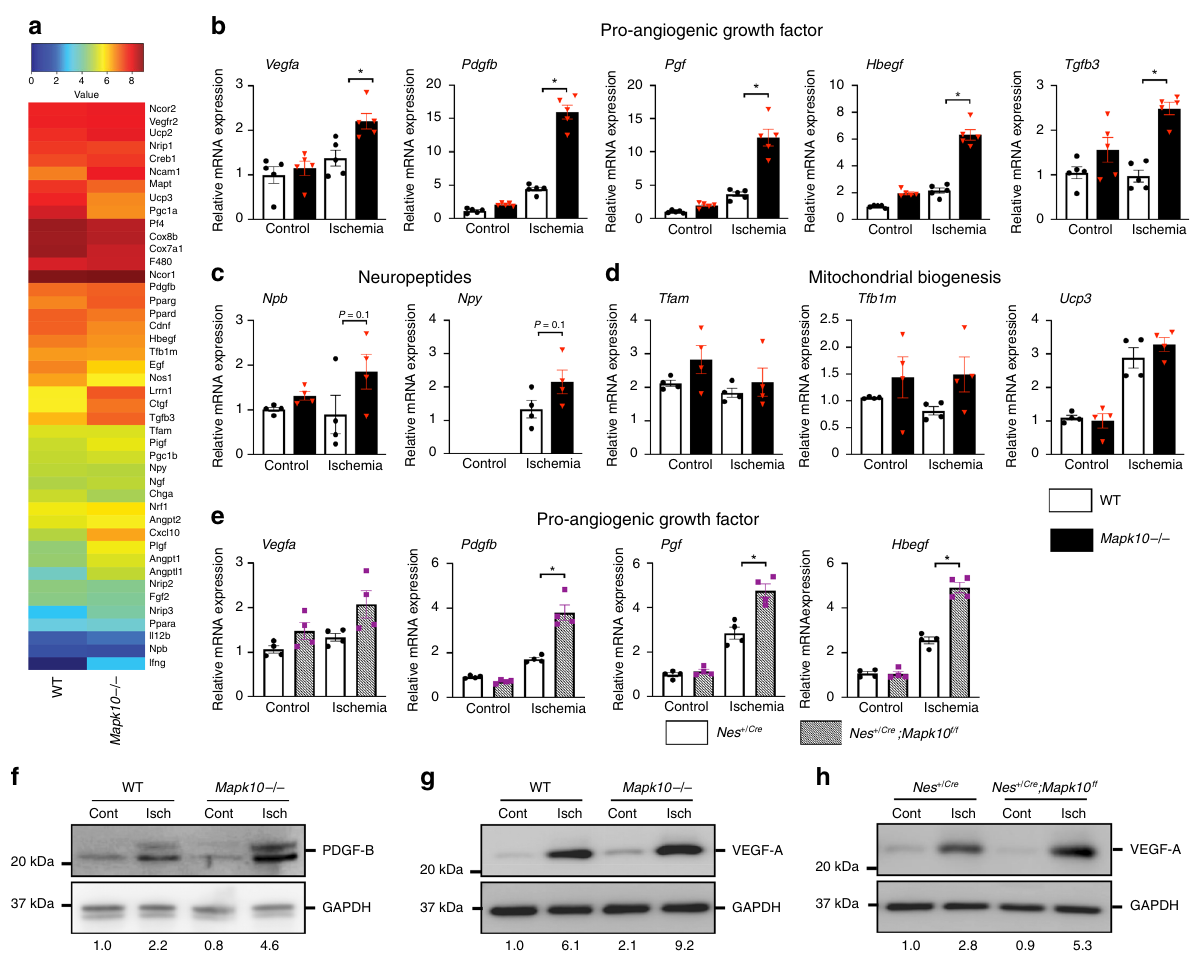
Fig. 3 Suppression of JNK3 activates pro-angiogenic genes in gastrocnemius muscle during ischemia. a Microarray was performed on pooled (three mice) gastrocnemius muscle three days post femoral artery ligation. b – d qRT-PCR was performed for different blood fl ow recovery related genes on gastrocnemius muscle from control and ischemic legs of WT and Mapk10 − / − mice 3 days post femoral artery ligation ( n = 4 in each group). e qRT-PCR was performed for growth factor related genes on gastrocnemius muscle from control and ischemic legs of Nes + /Cre and Ne s + /Cre ; Mapk10 f/f mice 3 days post femoral artery ligation ( n = 4 in each group). f – h Gastrocnemius muscle was isolated and immunoblots were performed as described. All the experiments have been repeated 3 – 6 times. Statistically signi fi cant differences between groups are indicated (* P < 0.05 by Student ’ s t test). The data are mean ± SEM. Source data are provided as a Source Data fi